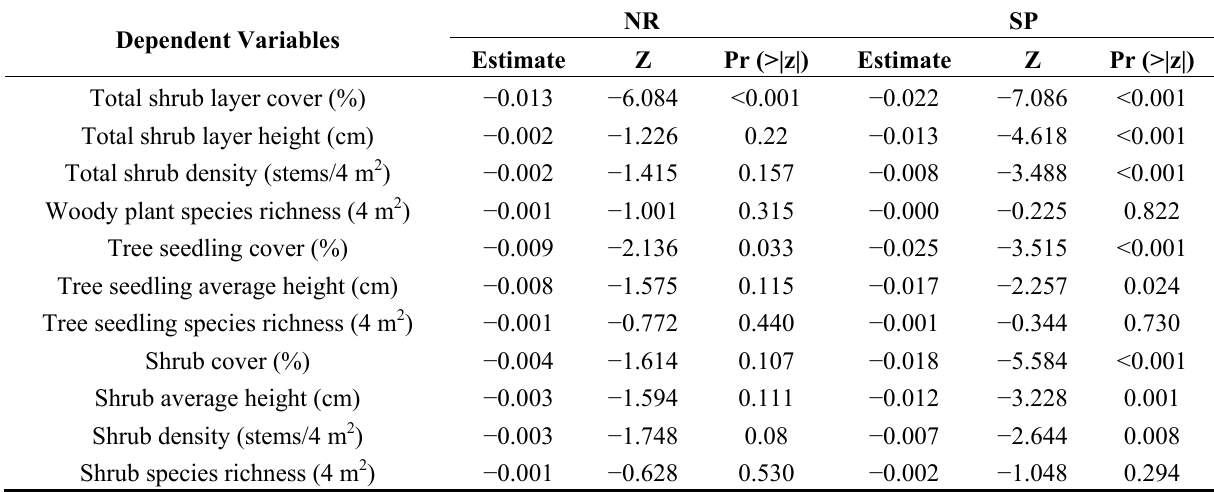
Table 3. Results of generalized linear mixed-effects models (GLMMs) for the effect of tree canopy cover on the understory shrub in the naturally regenerated forests (NR) and the reforested spruce forests (SP) on similar clear-cuts in the eastern Tibetan Plateau. Structure and species richness of the understory shrub were selected as dependent variables. Canopy cover was selected as an explanation variable and stand as a random factor, with three plots nested in each stand, and nine quadrats nested in each plot. In both cases, Poisson error distribution with log-link function was selected in GLMMs.